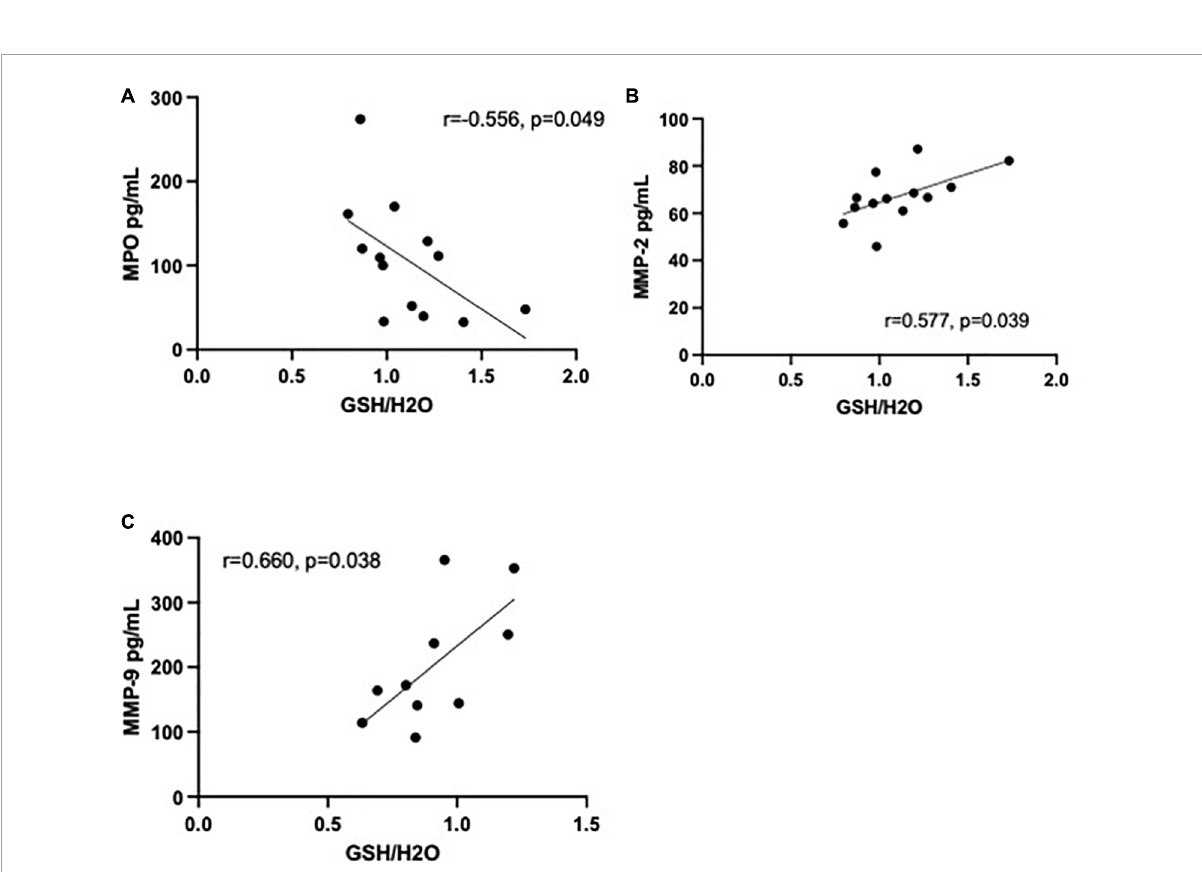
FIGURE3 Correlations between immunoinflammatory biomarkers and glutathione (GSH) in methamphetamine users (black circles). (A) Myeloperoxidase (MPO) (pg/mL) is negatively correlated with GSH ( r = − 0.556, p = 0.049, n = 13) in the anterior cingulate cortex (ACC) and (B) matrix metalloproteinase (MMP)-2 (pg/mL) is positively correlated with GSH ( r = 0.577, p = 0.039, n = 13) in the ACC. (C) MMP-9 (pg/mL) was positively correlated with GSH ( r = 0.660, p = 0.038, n = 10) in the dorsolateral prefrontal cortex